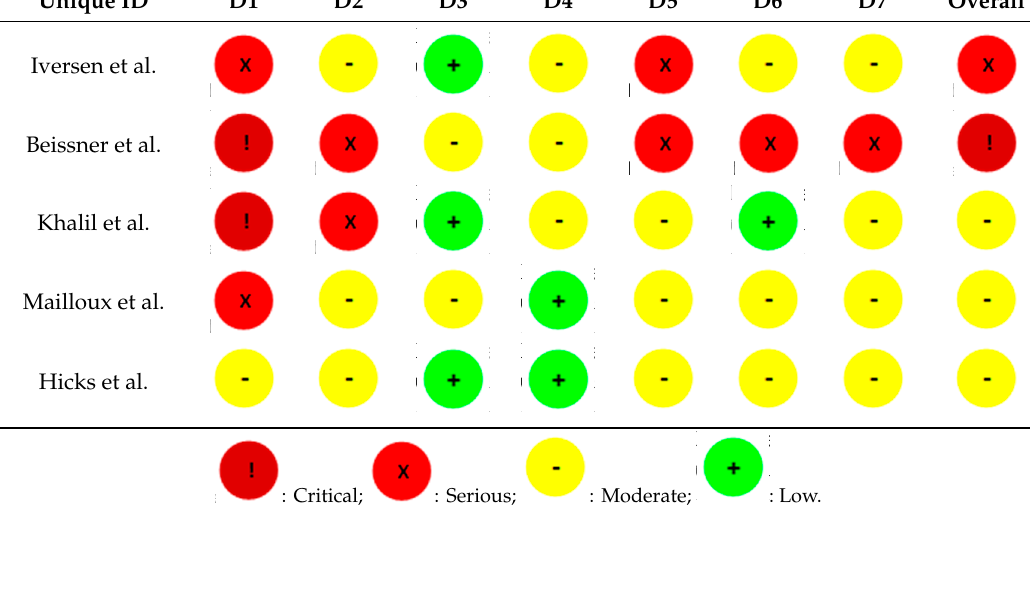
Table 2. Risk of bias in non-randomized studies of interventions (ROBINS-I).